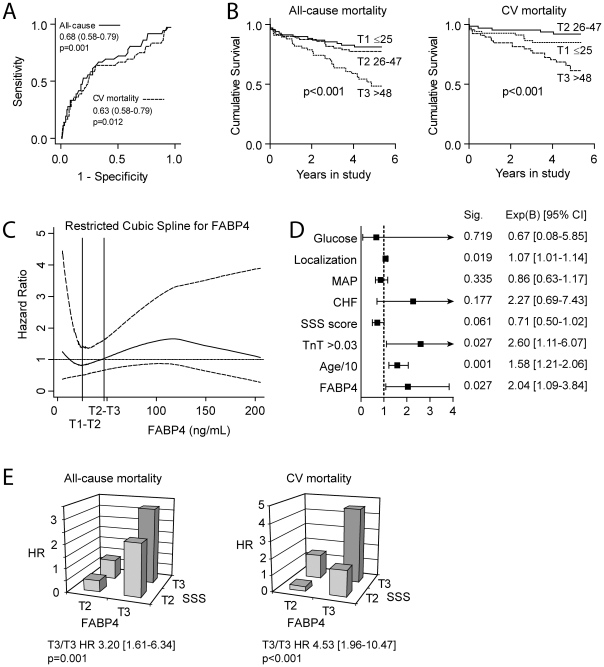
High plasma levels of FABP4 are associated with long-term mortality in patients with acute stroke.Panel A shows ROC curve analysis for the predictive value of FABP4 for all-cause and CV mortality. AUC and 95% CI are given. Panel B shows Kaplan-Meier curves with the cumulative incidence of all-cause and CV mortality during the entire study [median follow-up 4.4 years (interquartile range: 3.7 to 4.9 years)], according to tertiles of FABP4 at admission. Panel C shows the restricted cubic spline analysis of FABP4 in relation to all-cause mortality. Panel D shows multivariate analyses of FABP4 as an independent predictor of mortality in patients with acute stroke. *3rd tertile vs. lower 2. Panel E shows the increase in hazard ratios (HR) for the prediction of all-cause and CV mortality when combing tertiles of FABP4 and SSS score (inverse for SSS, ie. increasing severity with higher tertiles). Tertile 1 was set as reference and the combination of T3 for both parameters is shown.